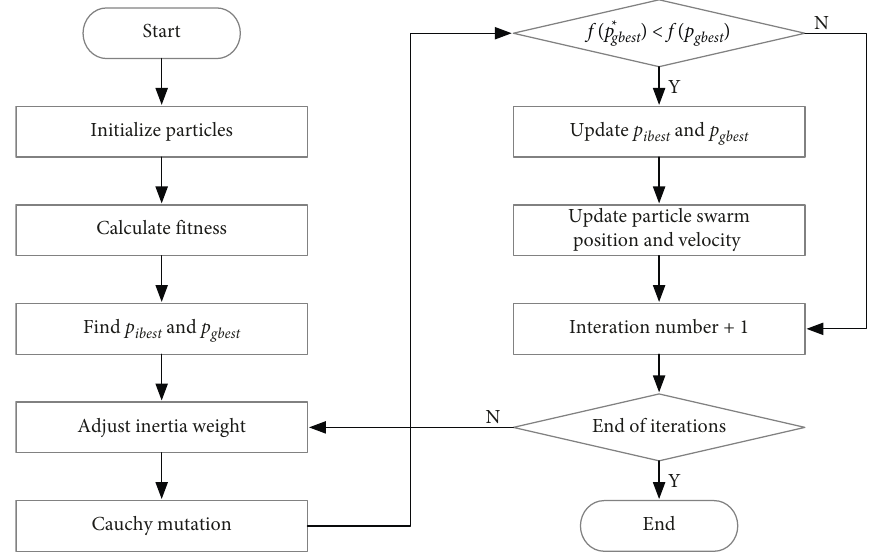
Figure 5: Flowchart of IPSO. Table 2: The node number of cities.